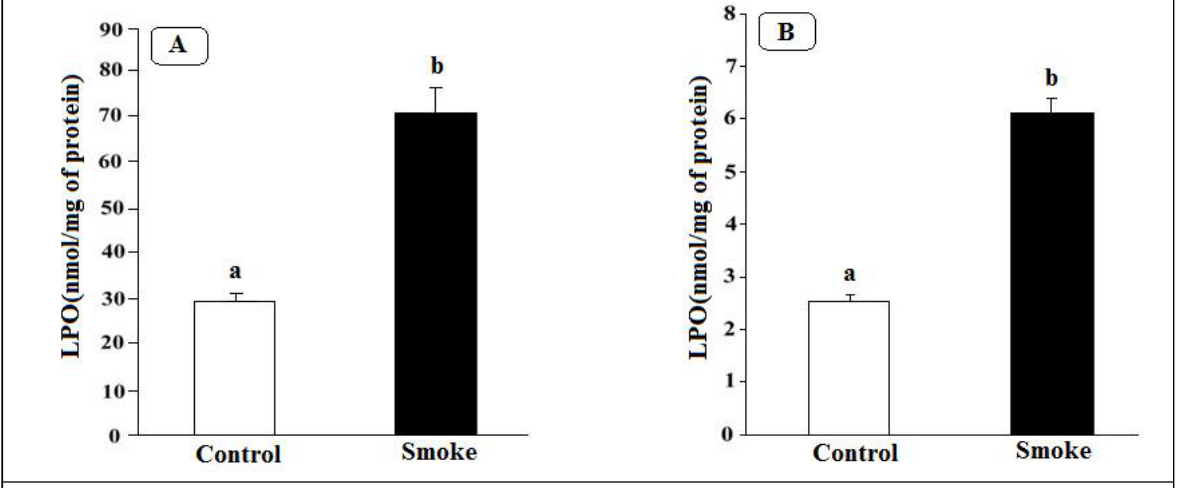
Figure 3: Increased lipid peroxidation was observed in erythrocytes and lung tissues upon cigarette smoke exposure. (A) in vivo cigarette smoking on lipid peroxidation of erythrocyte and(B) lung tissues. Results are mean ± SEM (n = 5). Bars with different alphabets are significantly different at p <